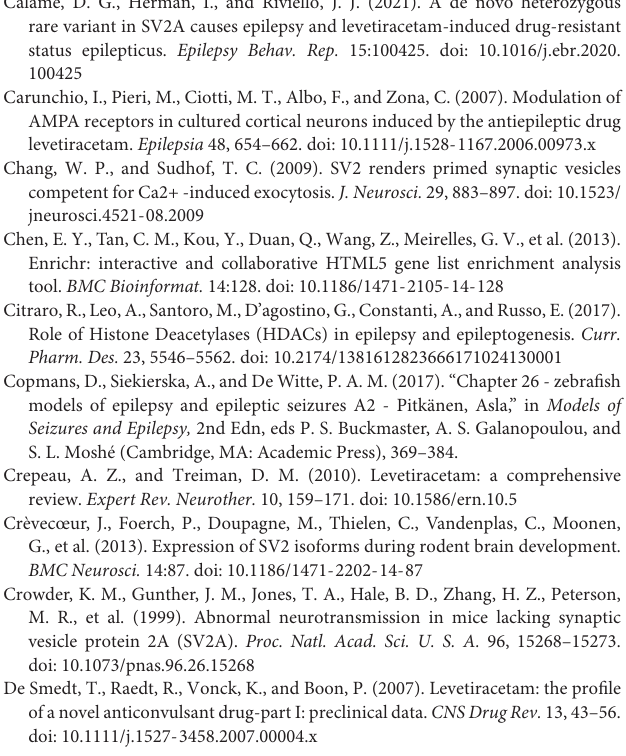
Supplementary Table 1 | Overview qPCR and HRM primers. Supplementary Table 2 | DEG list. Supplementary Table 3 | Enriched GO terms and KEGG